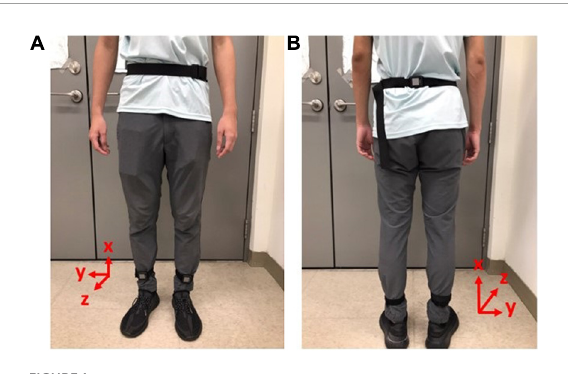
FIGURE1 Gait measurements by IMUs. Two IMUs were attached to the subjects’ lower limbs and one IMU was attached to the subjects’ waist to record the subjects’ kinematic data with a sampling rate of 128 Hz. (A) Front view. (B) Rear view.